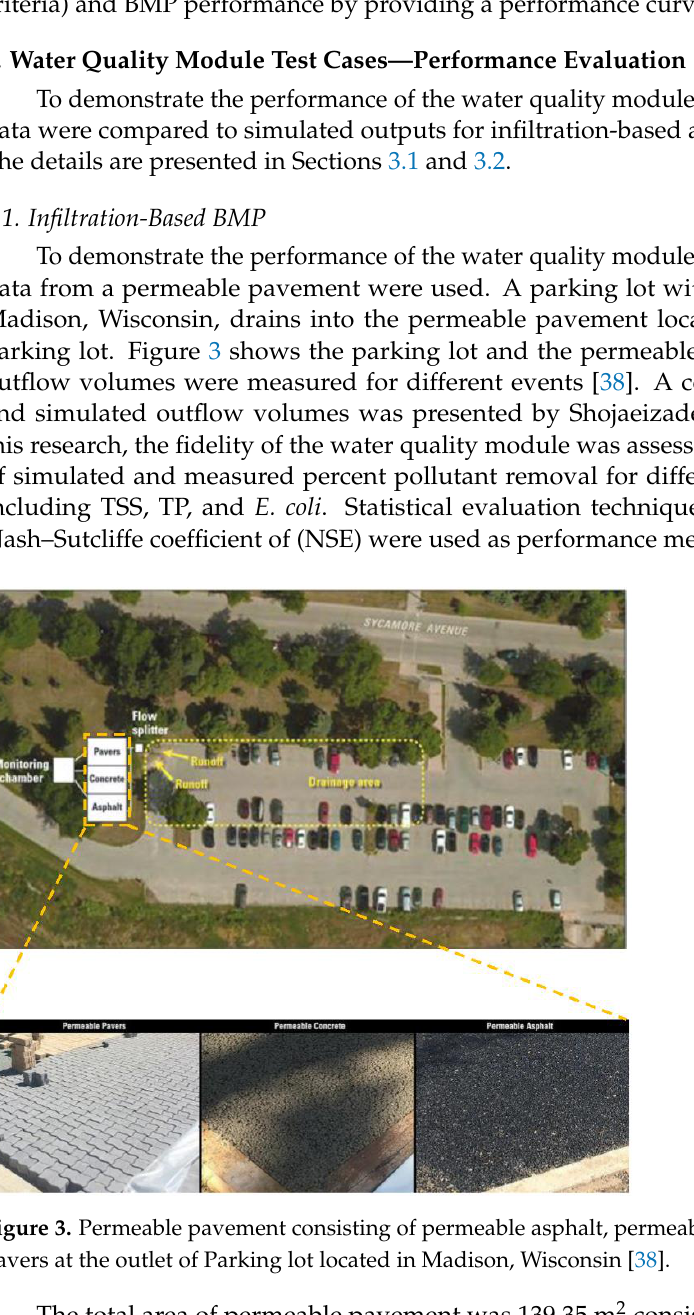
Table 2. List of parameters and their values used in the water quality module by pollutant type.